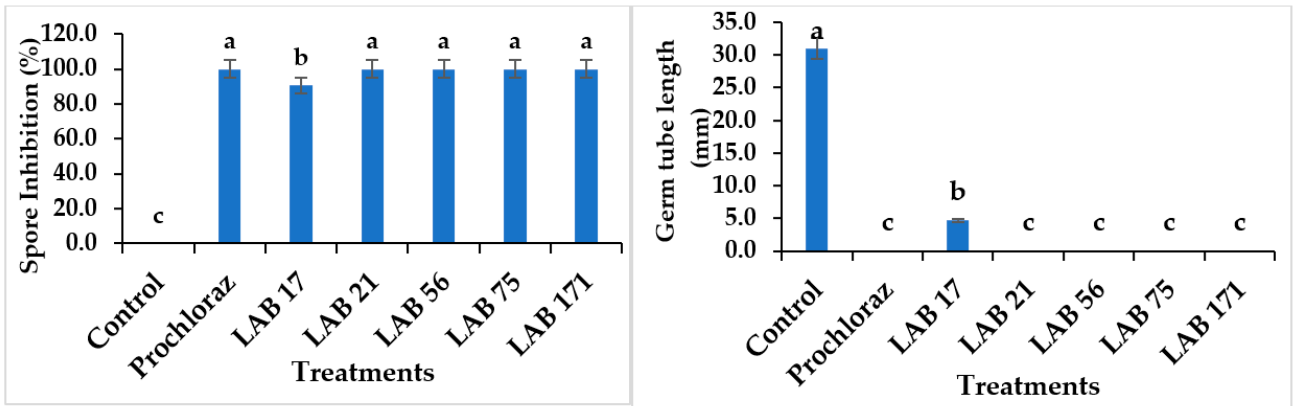
Figure 2. Effects of LAB strains on the percent inhibition of C. gloeosporioides spores and length of the germ tube. Similar columns with different letters were significantly different at p ≤ 0.05 level.